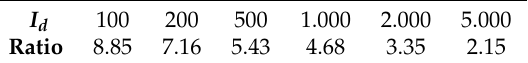
ratio to log I d . F